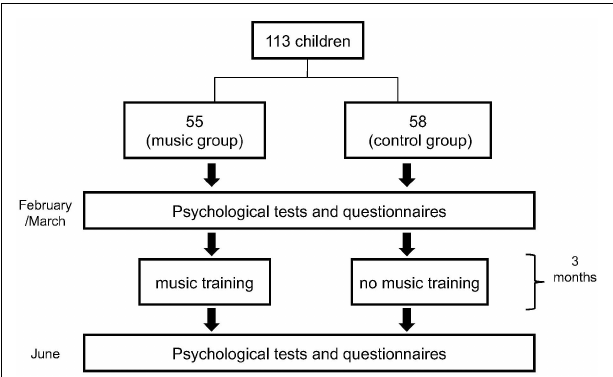
FIGURE 1 | Trial profile showing the different phases of the